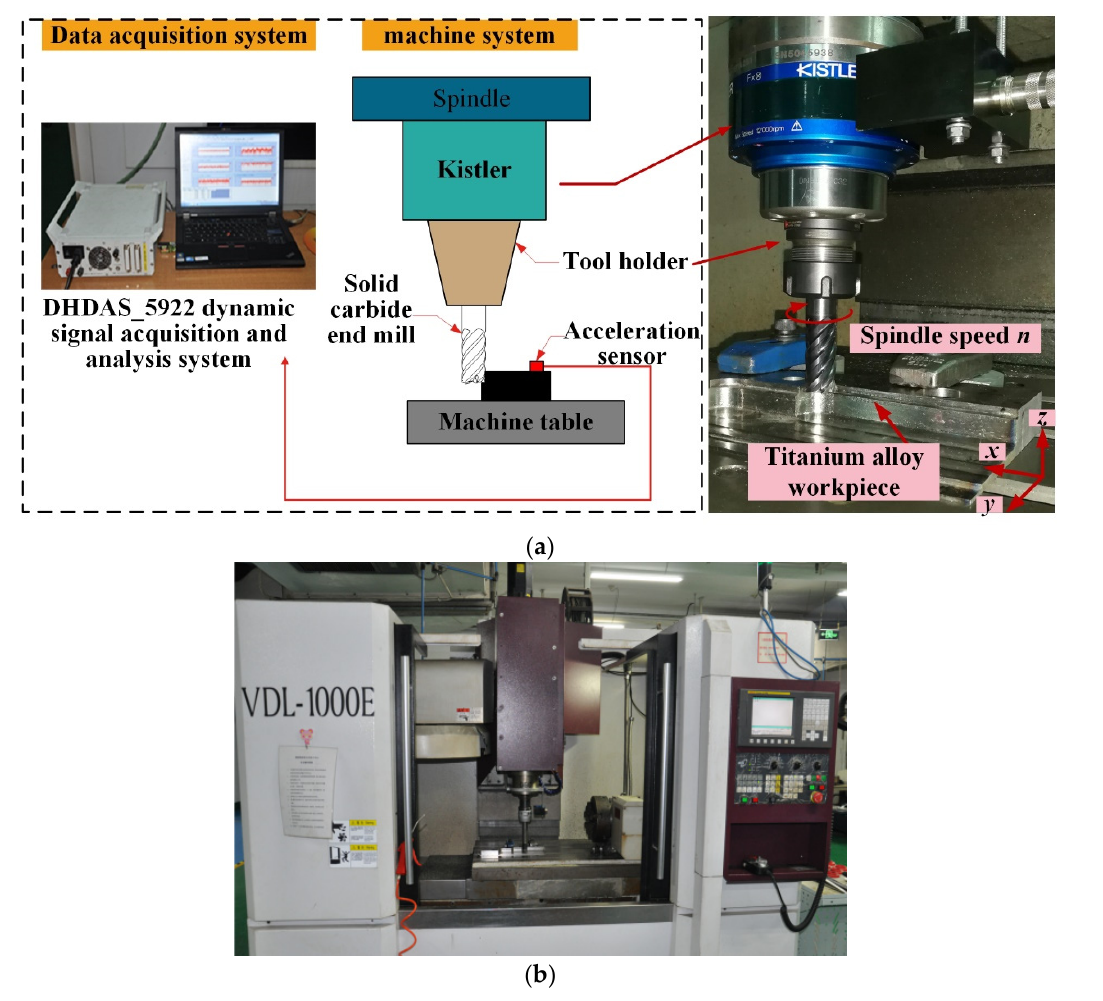
Figure 14. Milling experimental device: ( a ) Milling experiment site. ( b ) Three-axis milling machining center.